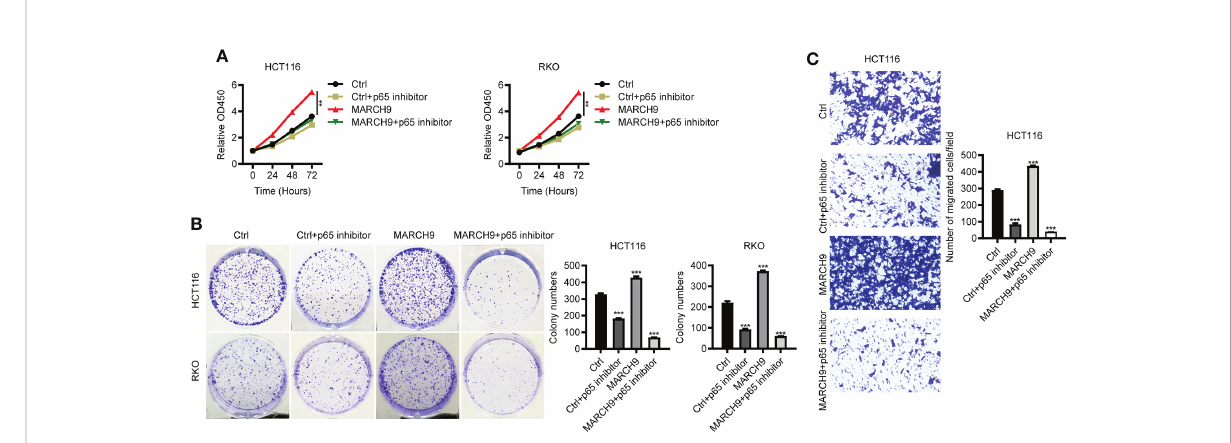
FIGURE 6 MARCH9 accelerated CRC progression by promoting p65. (A) The cell viability of two CRC cell lines transfected with Ctrl plasmids, Ctrl plasmids +p65 inhibitor, MARCH9 plasmids and MARCH9 plasmids+p65 inhibitor at 24, 48, and 72h using a CCK-8 assay. (B) Cell colony formation results of two CRC cell lines transfected with Ctrl plasmids, Ctrl plasmids+p65 inhibitor, MARCH9 plasmids and MARCH9 plasmids+p65 inhibitor at 14 days. (C) The migration ability of HCT116 and RKO cells transfected with Ctrl plasmids, Ctrl plasmids+p65 inhibitor, MARCH9 plasmids and